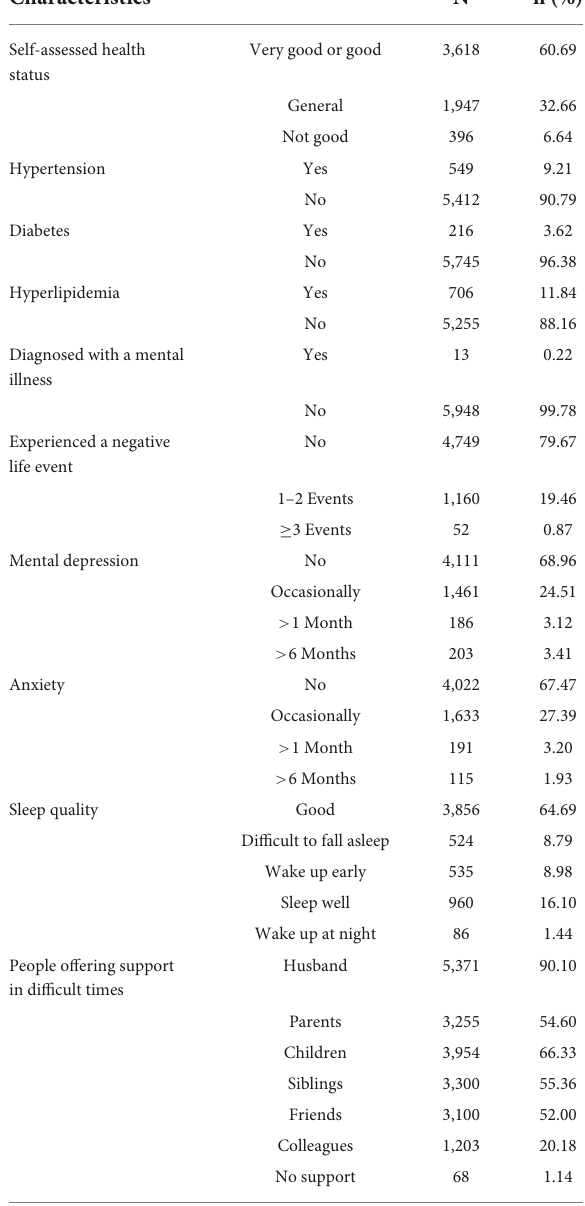
TABLE 4 Health-related emotional factors of the cervical cancer screening